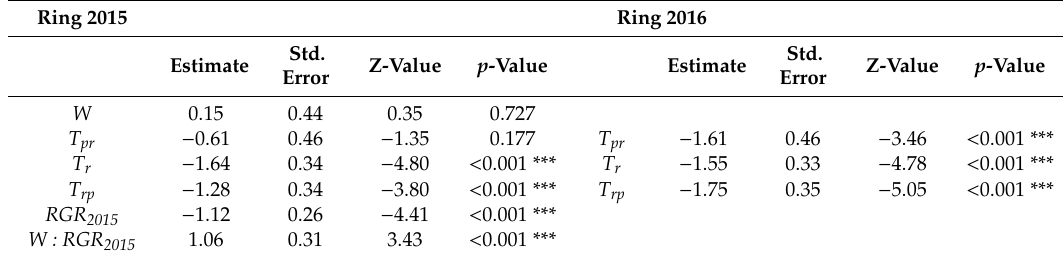
Table 7. Statistics from the cumulative logistic regression models with the level of vessel ring closure at the onset of the earlywood in the second and third growing season as response variables. The standard level of the categorical variable taxon of the mother tree ( T ) was Q. petraea , to which the other taxa were compared with. T pr : long stalked intermediate form, T r : Q. robur , T rp : short-stalked intermediate form. RGR 2015 : relative growth rate in height in the second growing season. W : adjusted relative extractable water in